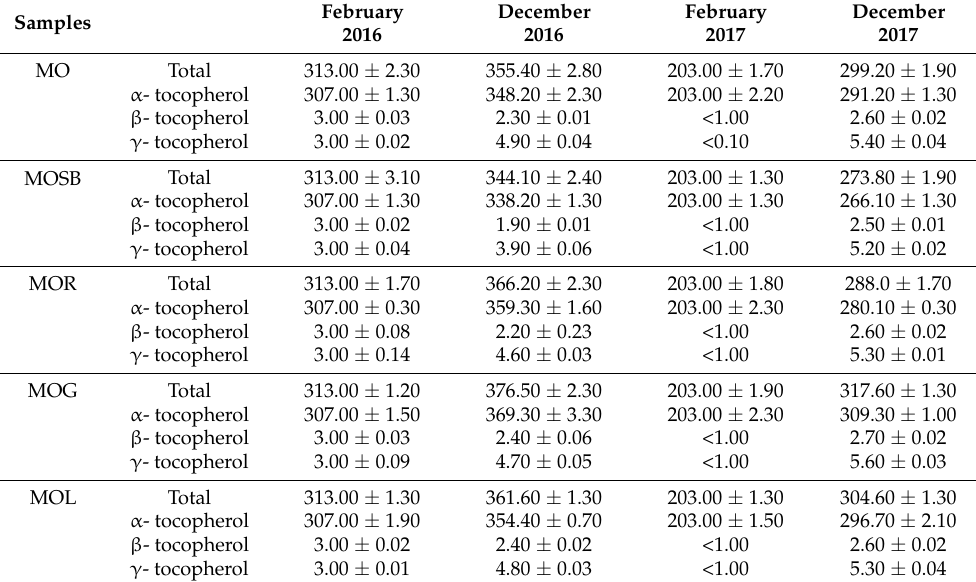
Table 11. Tocopherols (mg/kg oil) of all olive oils.